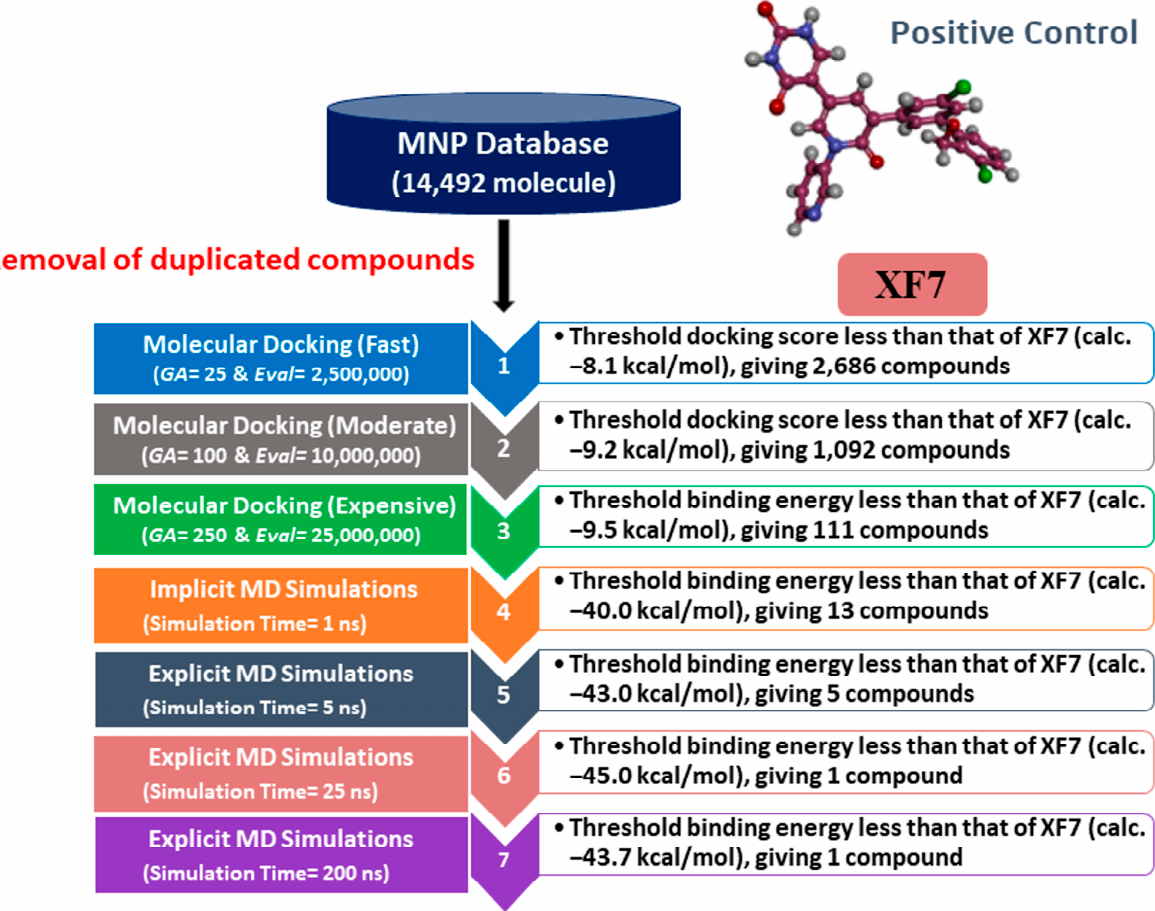
Figure 1. A schematic diagram of the utilized in silico computations in the filtration process of ma- rine natural products (MNP) database. natural products (MNP)